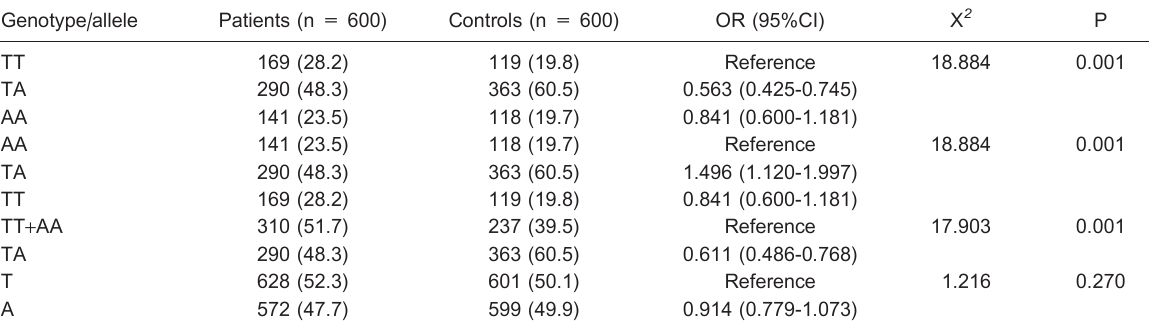
Table 2. Comparison of genotype and allele frequency between patients and